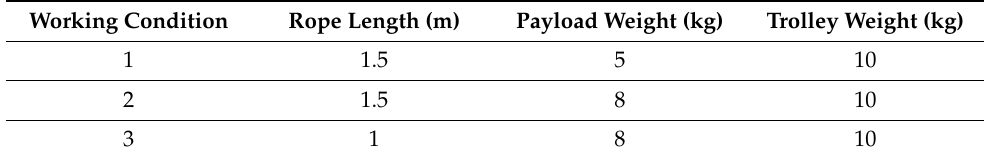
Table 5. Parameters of the crane under the other three working conditions. Working Condition